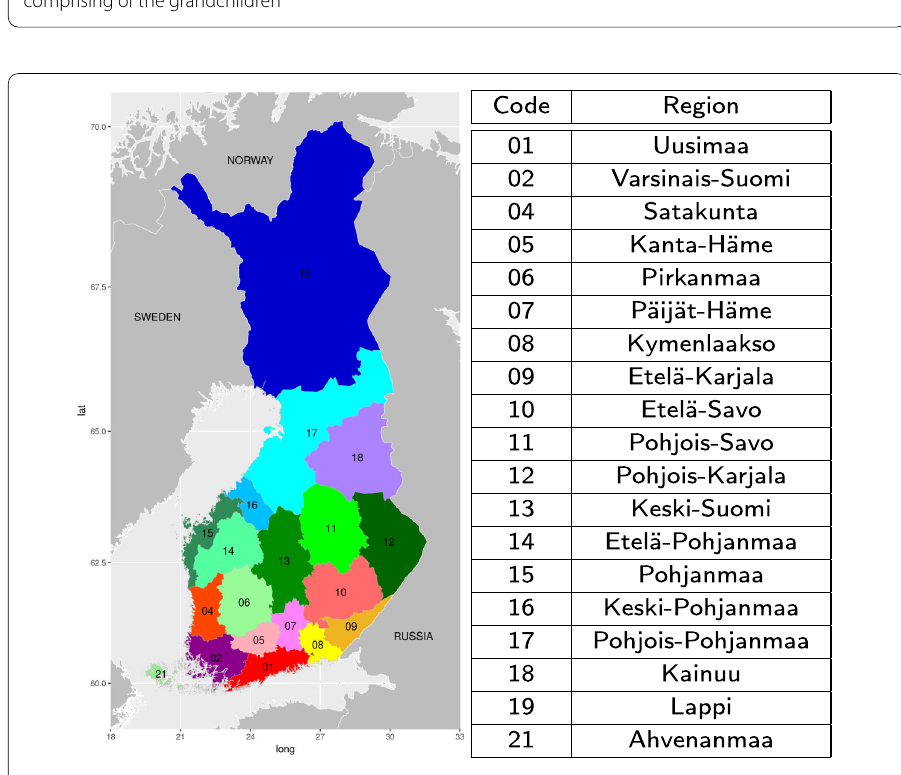
Figure 2 Map showing the 19 different administrative regions (“Maakunta”) of Finland. The names are provided on the right with the corresponding codes [21]. The numbers missing (03 and 20) from the sequence for codes correspond to regions that were historically merged with other neighbouring regions. The colouring scheme used above to denote the regions is the same as the one used to denote the nodes in the network of families based on regions of origin